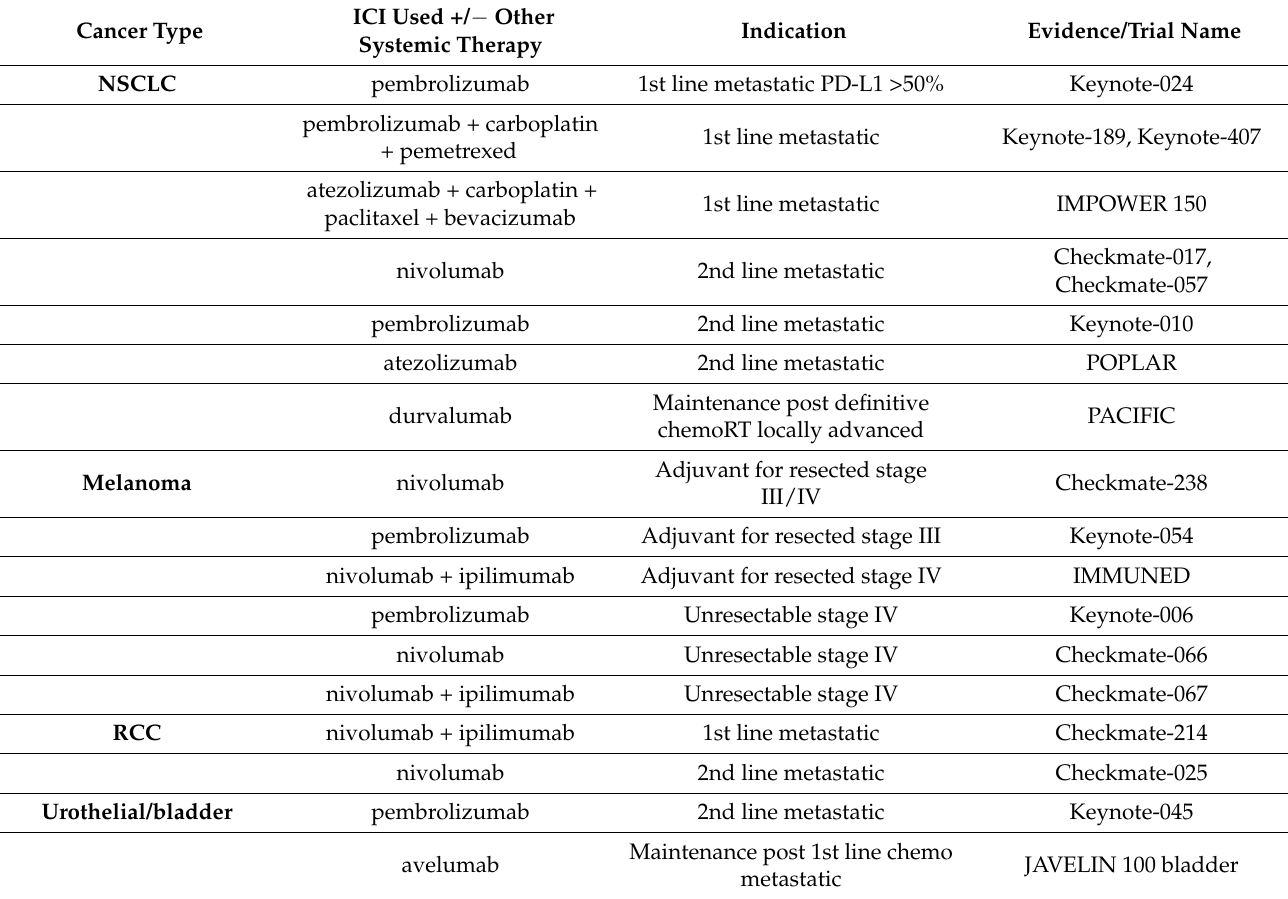
Table 3. Summary of ICI therapy in NSCLC, melanoma, RCC and urothelial/bladder cancer. Cancer